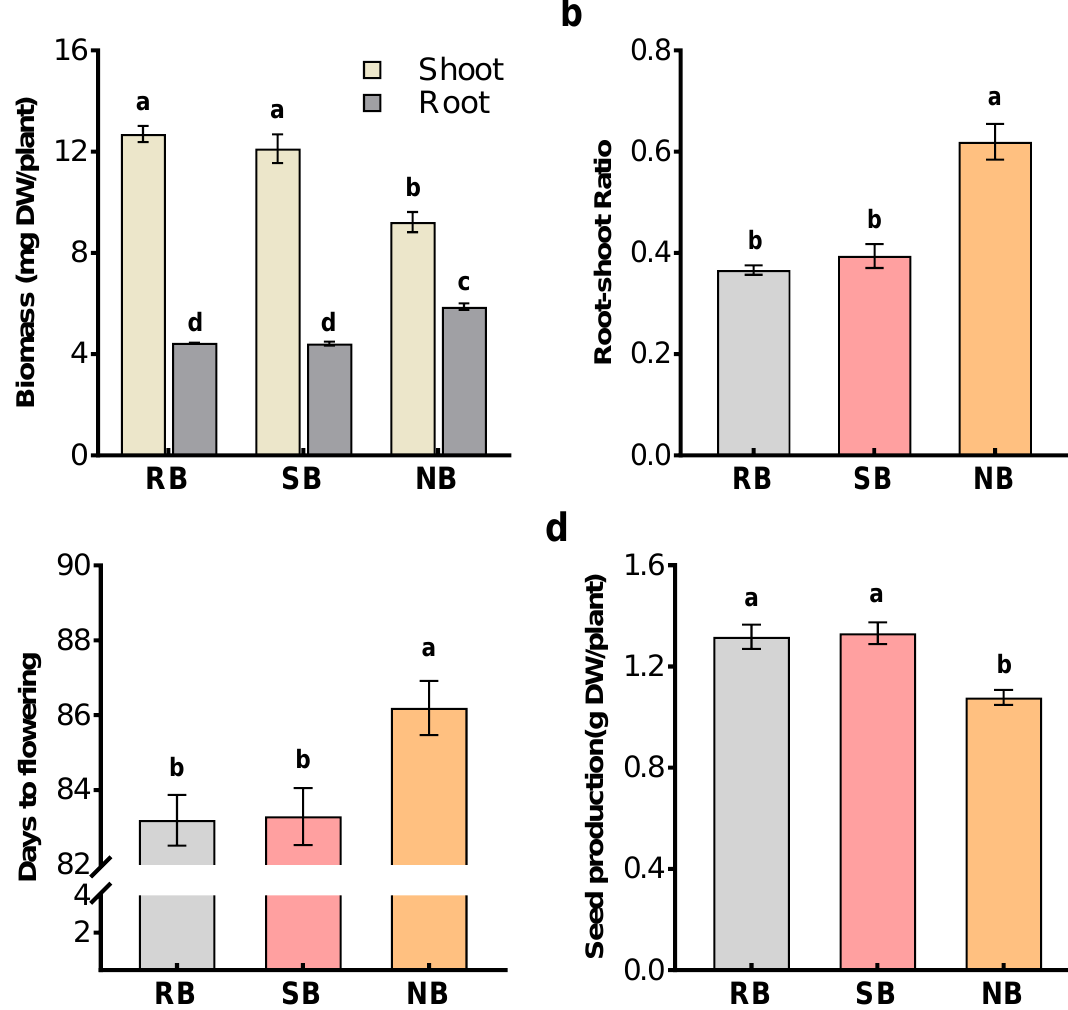
Figure 1. Biomass ( a ), Root-shoot radio ( b ), flowering time ( c ), and seed production ( d ) of penoxsulam-resistant barnyardgrass ( RB ) in the presence of penoxsulam-susceptible barnyardgrass ( SB ) and normal barnyardgrass ( NB ). Values plotted are means plus/minus SE. Columns with the same letter are not significantly different at p < 0.05 according to ANOVA, followed by Tukey HSD tests.